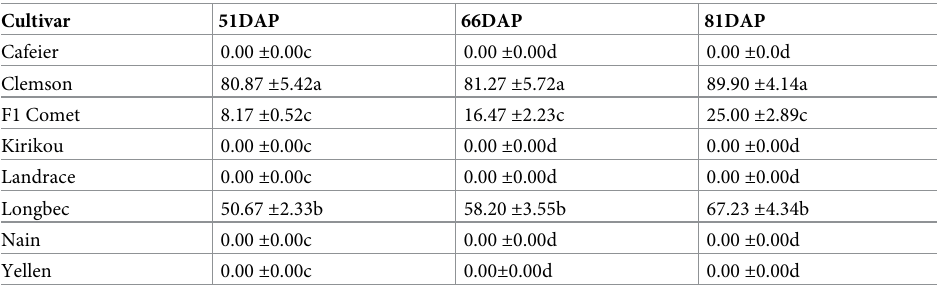
Table 11. Pest and disease incidence on okra cultivars.